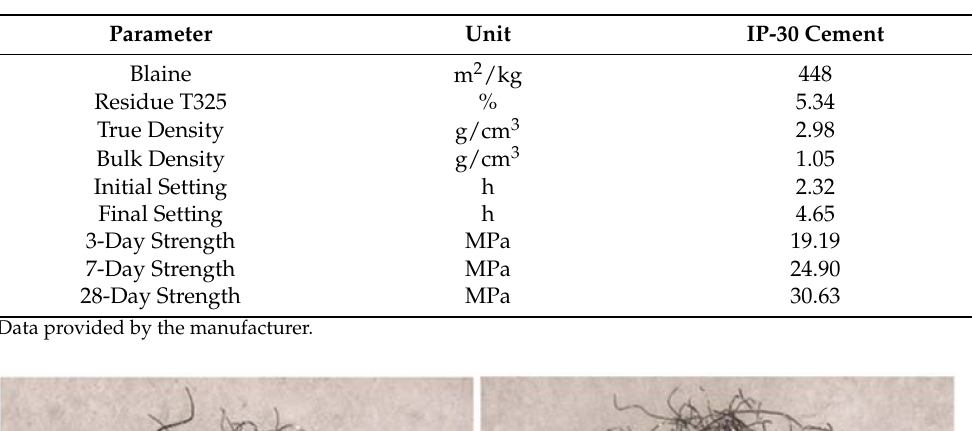
Table 2. Physical analysis for IP-30 cement.